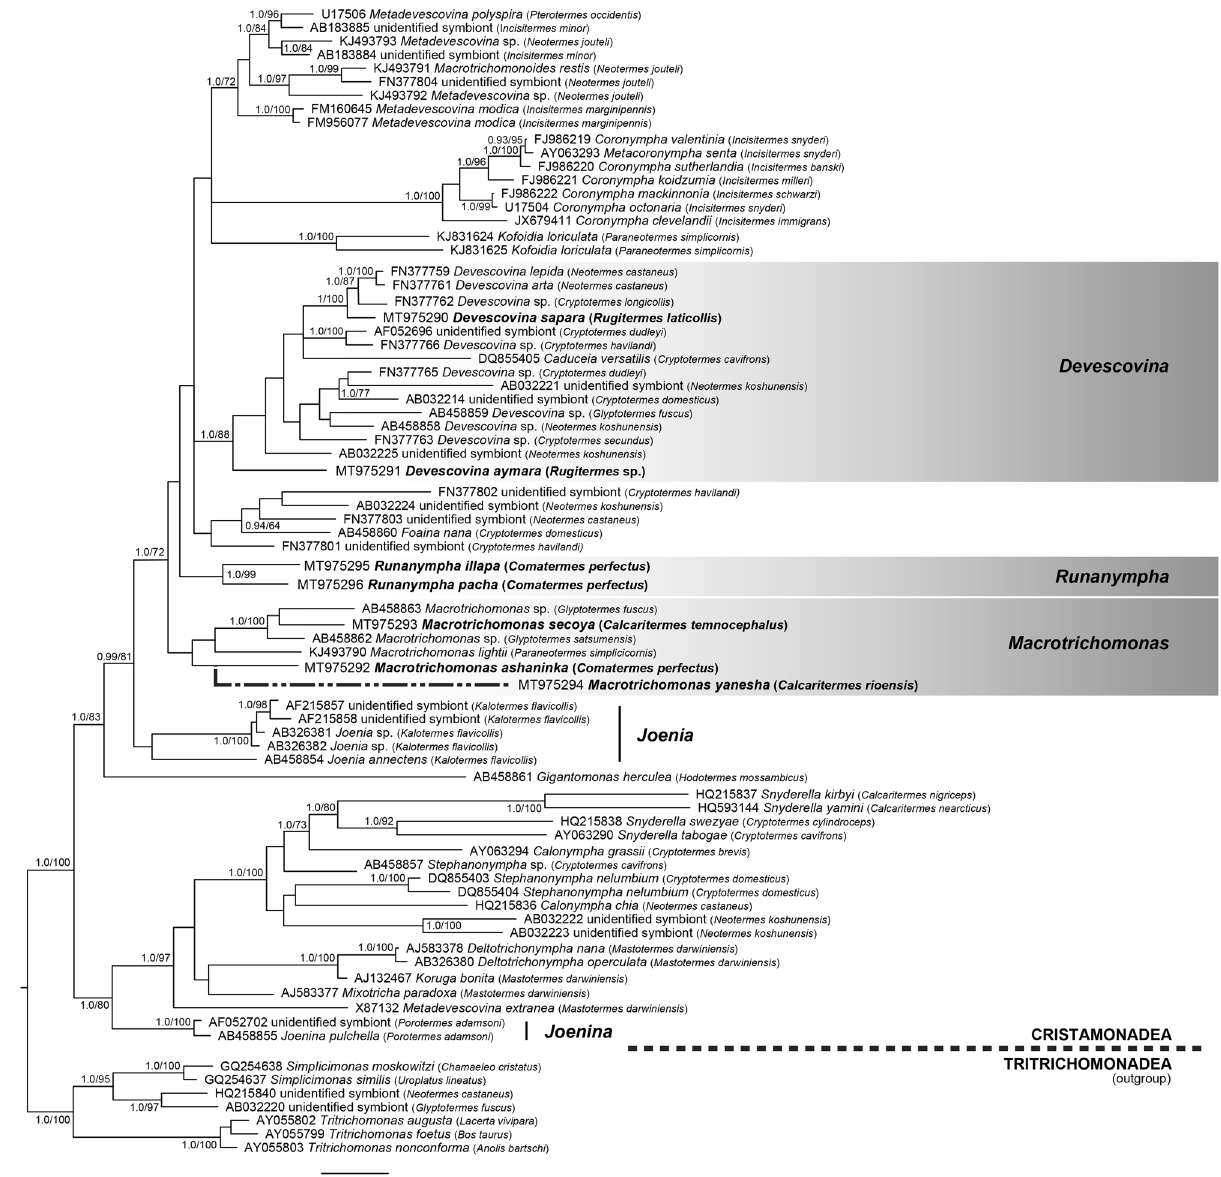
Figure 5. Bayesian phylogeny of SSU rRNA sequences of the class Cristamonadea (1528 sites). The tree is rooted with sequences from the closest known relatives to the Cristamonadea, members of the class Tritrichomonadea. Sequences obtained in this study are in bold type. Taxon names include GenBank accession numbers and the name of the termite host. Numerical values at nodes indicate Bayesian posterior probability (where greater than 0.90) and % ML bootstrap support (out of 1000 replicates, where in agreement with the Bayesian topology and greater than 60%). The non-uniform dashed line represents the manual addition of M. yanesha to the tree after analyses. Sequences assigned to or likely belonging to the joeniid genera Joenia and Joenina are denoted by a thick vertical bar. Tree figures were generated using the FigTree software v1.4.4 (http:// tree. bio. ed. ac. uk/ softw are/ figtr ee/) and edited in Adobe Illustrator (https:// adobe. com/ produ cts/ illus